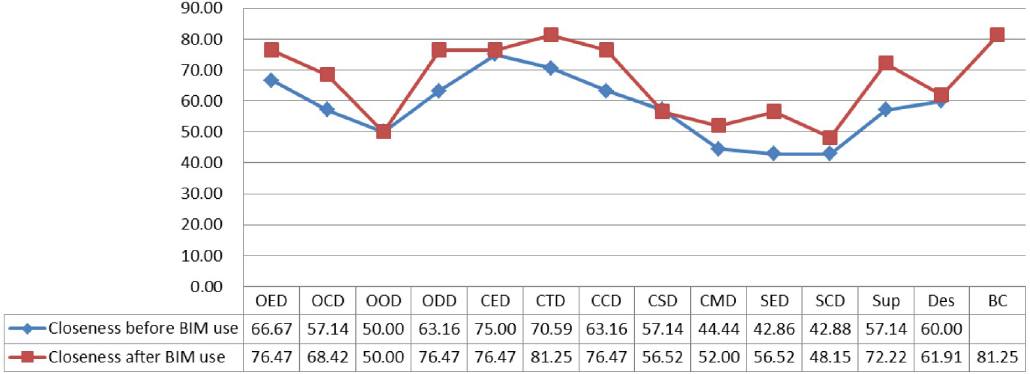
Fig 4. The closeness centrality in project communication